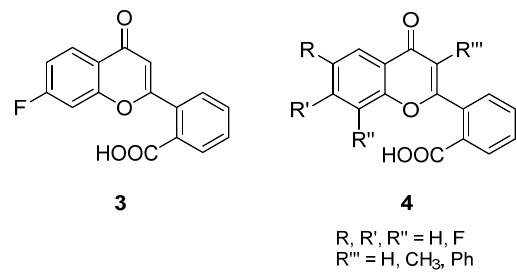
Figure 3. Fluorinated FAA derivatives.